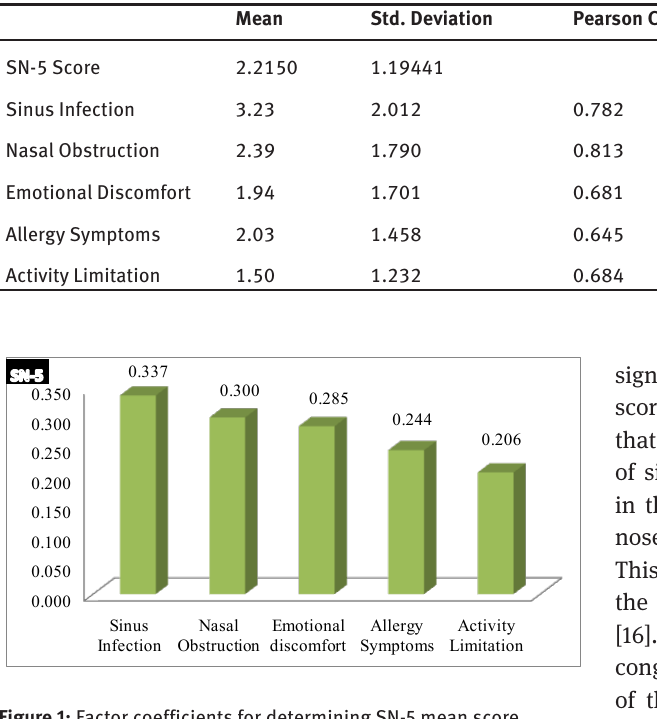
Figure 1: Factor coefficients for determining SN-5 mean